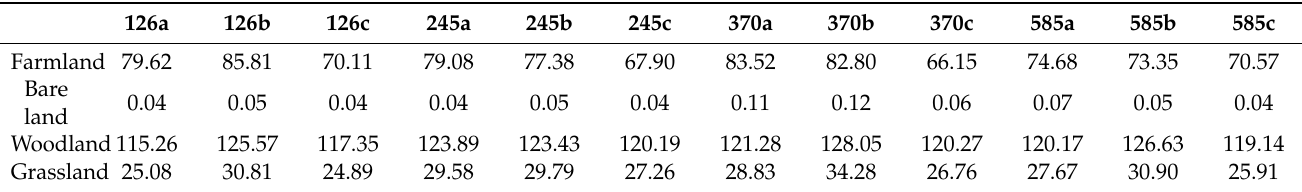
Table 2. Predicted area combined with land use type (‘a’ represents BCC-CSM2-MR, ‘b’ represents CanESM5, ‘c’ represents MRI-ESM2-0).